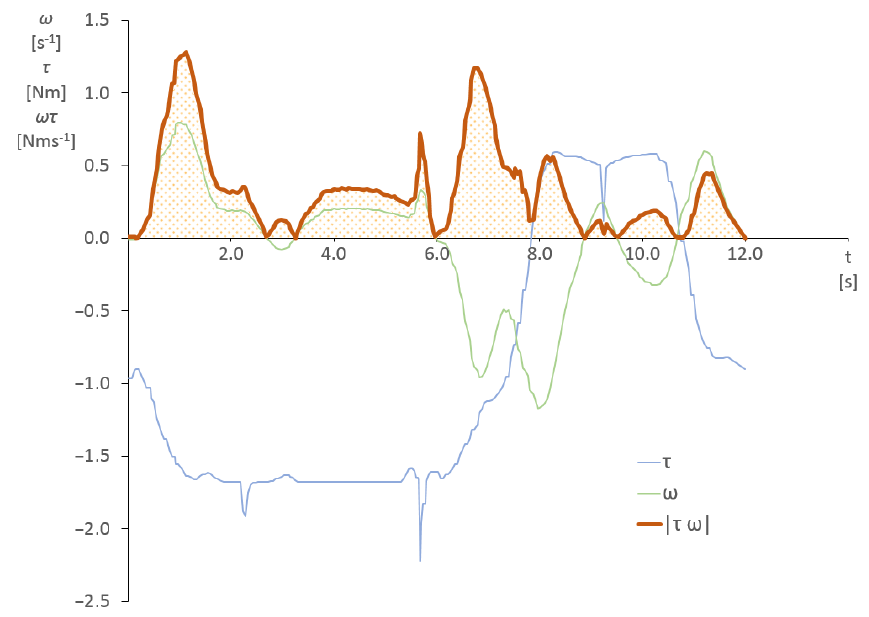
Figure 1. Example of the time progression of joint torque τ and angular velocity ω ; the dotted area represents the meaning of the value W calculated as the integral of absolute value | τω |